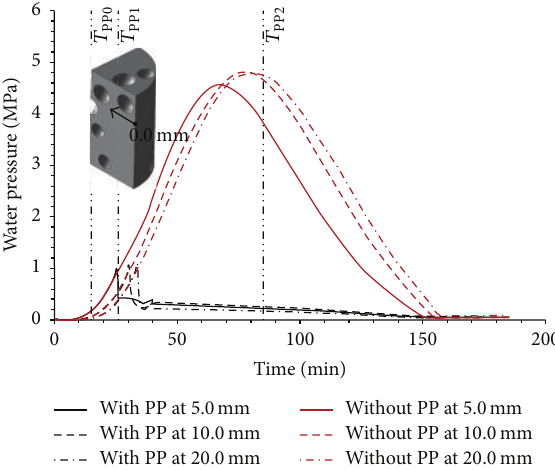
Figure 12: Water pressure versus time at different sample positions with and without PP